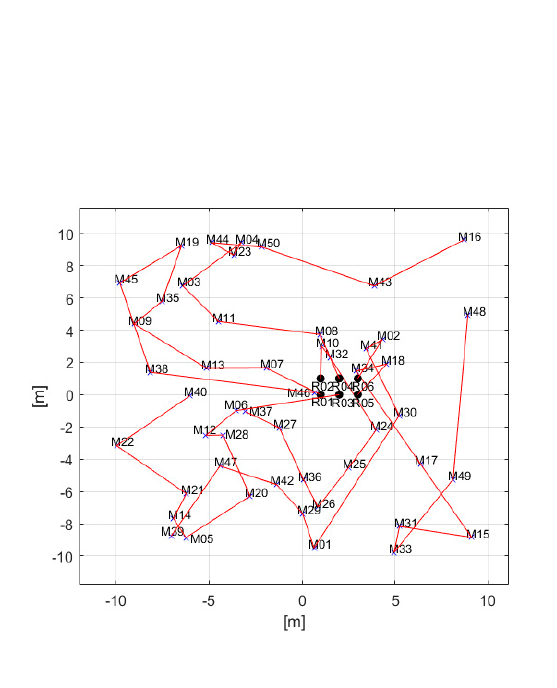
Figure 7. The results for huge case using CBBA: ( a ) 2D situation map; ( b ) timetable.